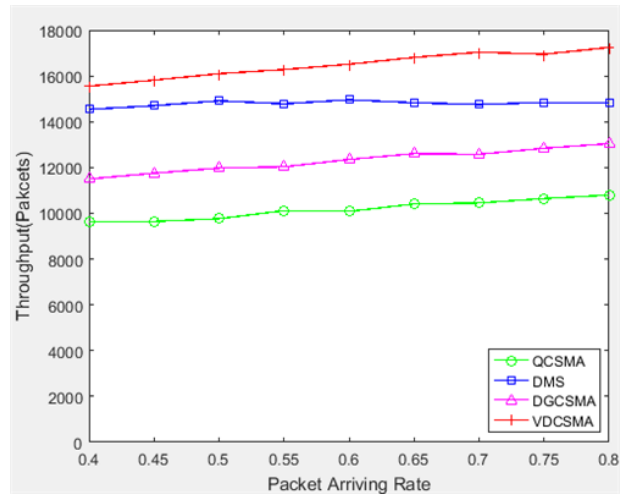
Figure 9. Total throughput: λ ∈ [ 0.4,0.8 ] .